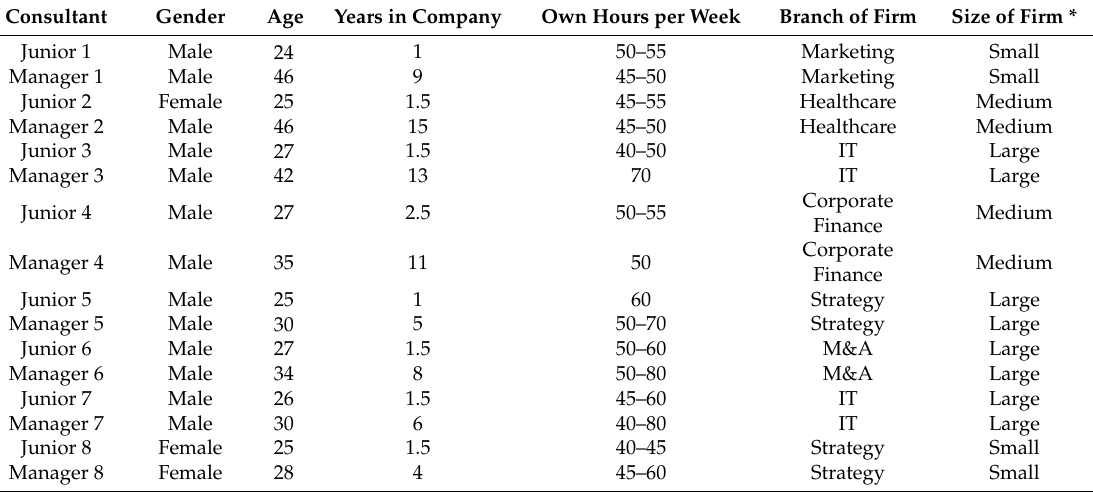
Table 2. Interviewee